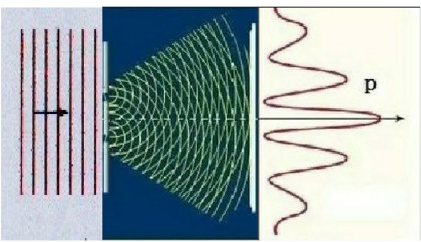
Figure 2. Interference of a particle plane wave in Young’s double slit